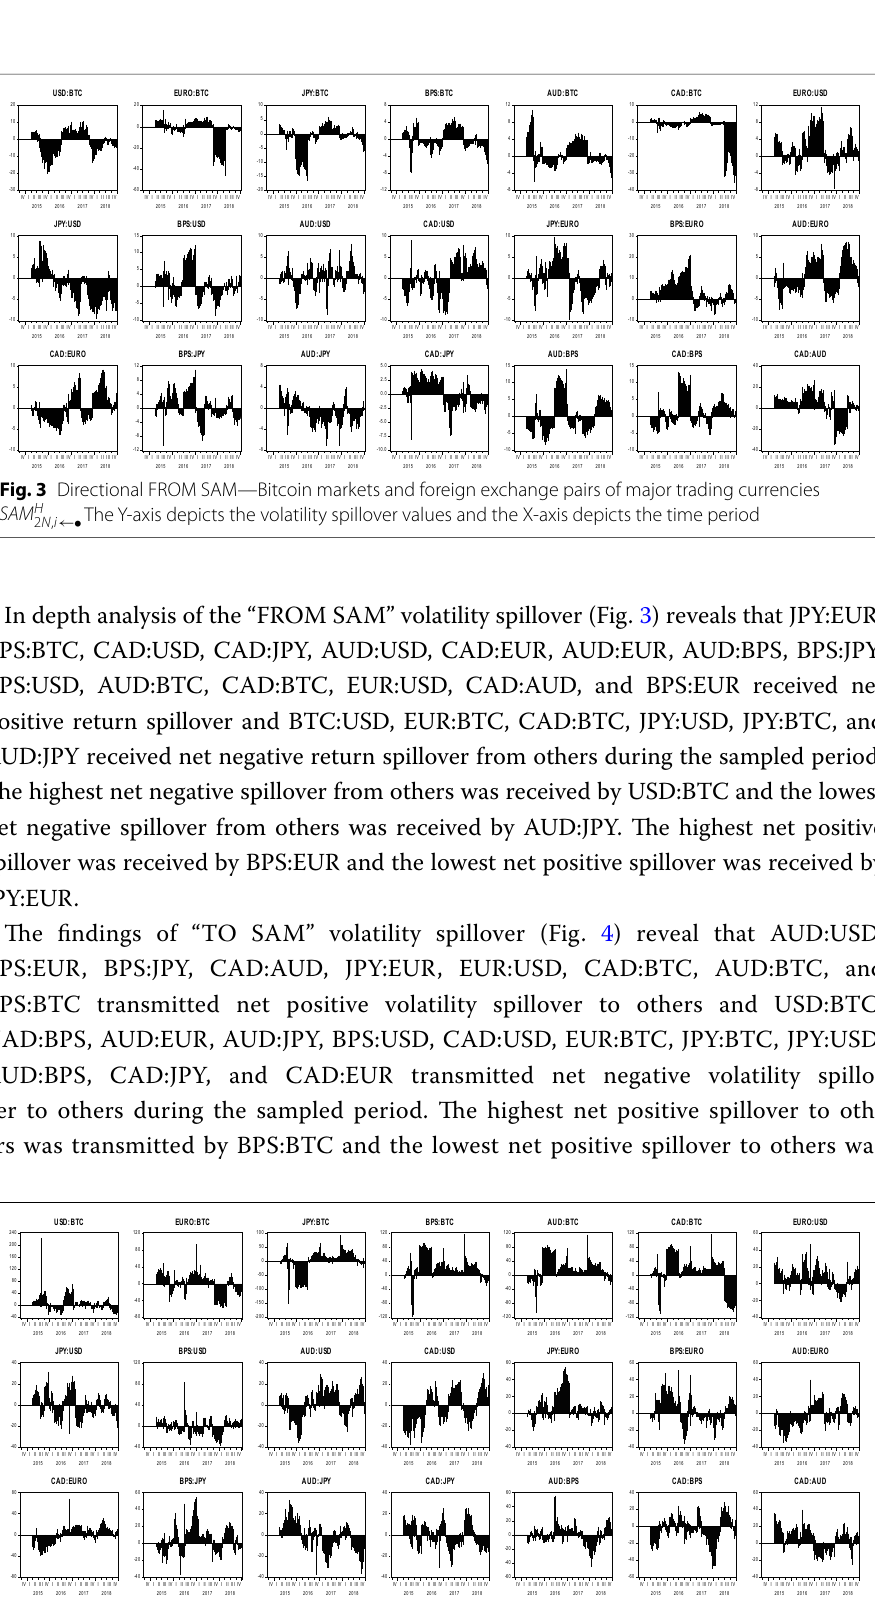
Fig. 4 Directional TO SAM—Bitcoin market and foreign exchange pairs of major trading currencies SAM H 2 N , i →• The Y-axis depicts the volatility spillover values and the X-axis depicts the time